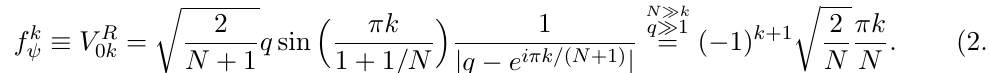
k -th column of the V R rotation matrix, V R j -th node. In particular, the pro(cid:12)le of the k -th clockwork takes the following value on the 0-th